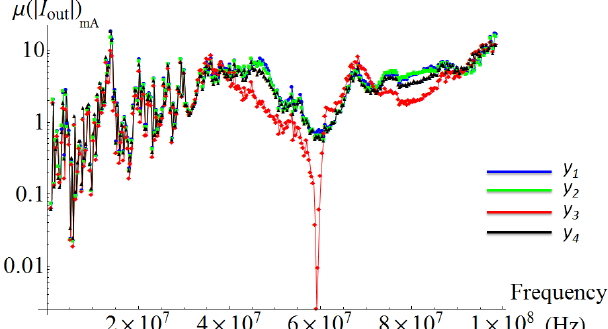
Figure 6: Computation of the end-current mean magnitude for the four configurations of the MC simulations